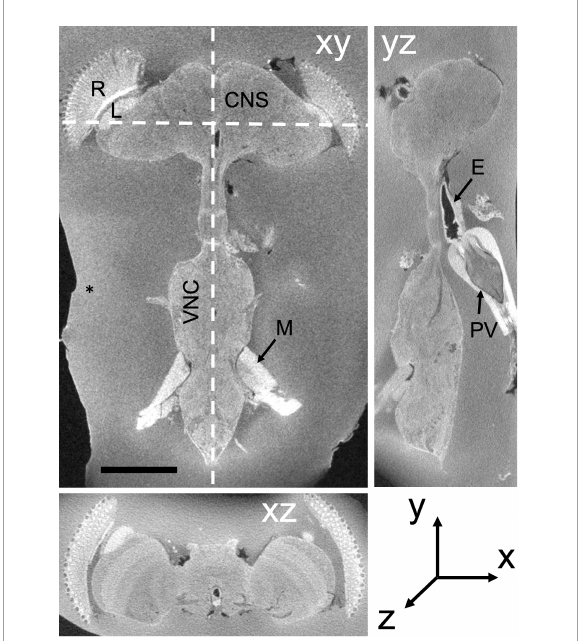
FIGURE1 Soft X-ray dissected Drosophila CNS in three orthogonal planes, xy, yz, and xz. xy: frontal slice of the entire CNS, including the VNC. yz sagittal plane. xz transverse plane. Different zones in the surrounding BSA reveal successive additions of the cross-linked protein. E, esophagus; L, lamina; M, muscle; R, retina; PV, proventriculus. Scale bar in xy: 200 µ